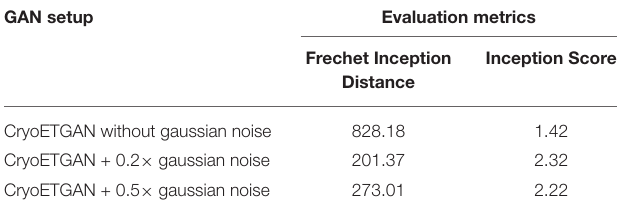
TABLE 3 | Ablation study to demonstrate the performance impact of applying zero-mean Gaussian noise applied on density maps w.r.t. Frechet Inception Distance and Inception Score.